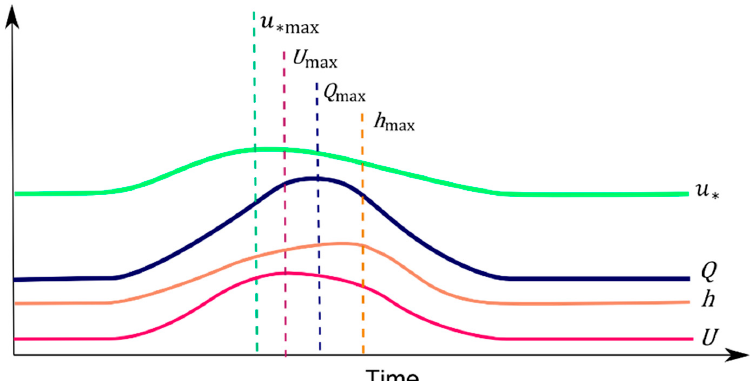
Figure 2. Schematic representation of temporal variation of flow parameters, indicating the sequence of peak values. Based on [56,61], u * max —maximum friction velocity (m/s), U max —maximum mean flow velocity (m/s), Q max —maximum flow rate (m/s), h max —maximum flow depth (m).